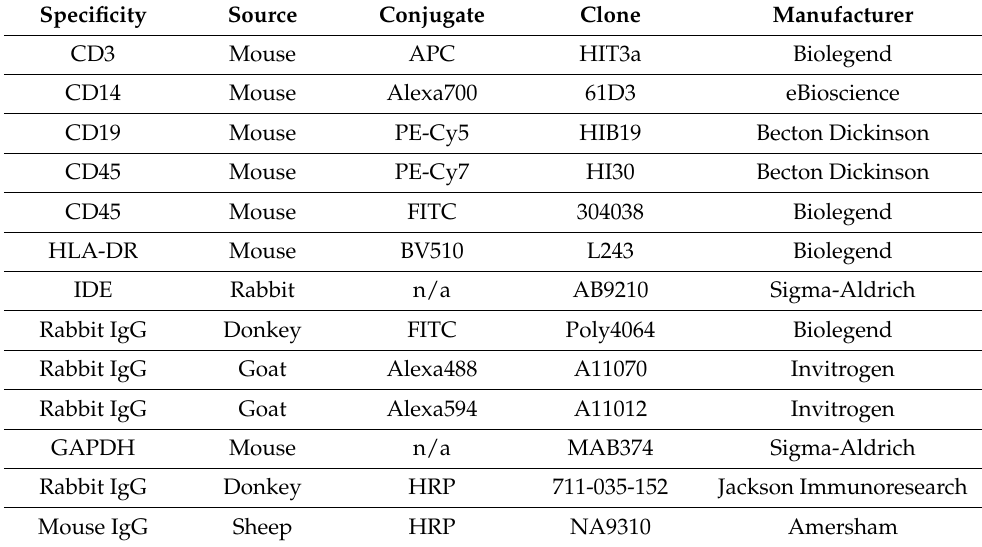
Table 3. Specificity, source, clone, conjugate, and manufacturer of the antibodies used in this